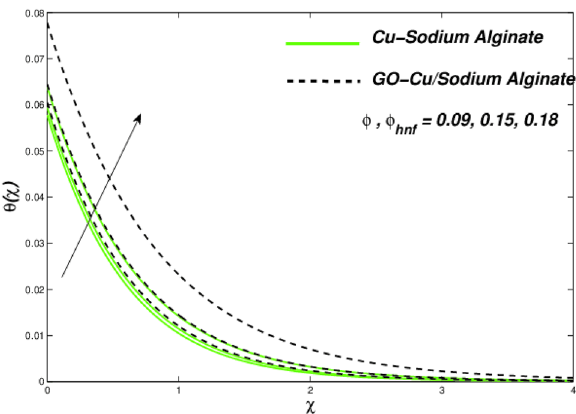
Figure 16. Temperature variations with respect to φ as well as φ hnf .